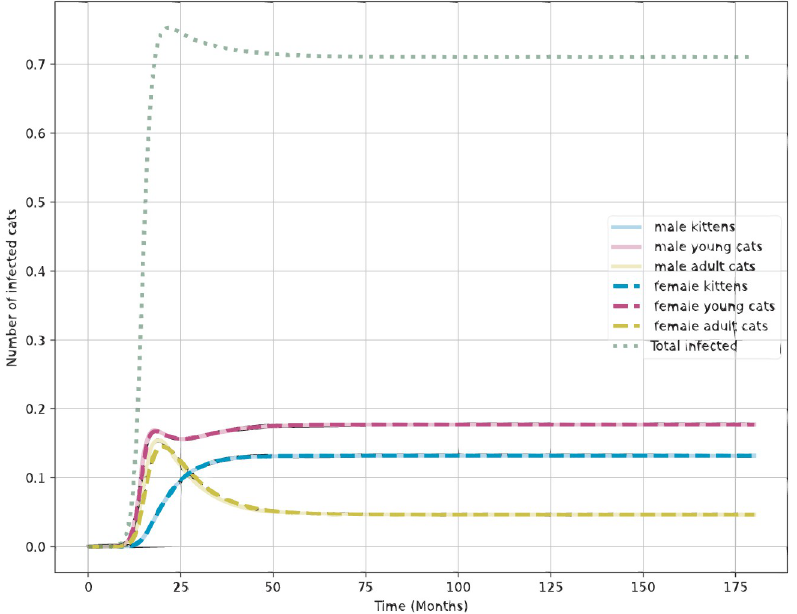
Fig 3. Establishment of sporotrichosis on an entirely susceptible feline population at the demographic equilibrium shown in Fig 2, in the absence of controls. The y-axis is scale to show the fraction of the entire population.